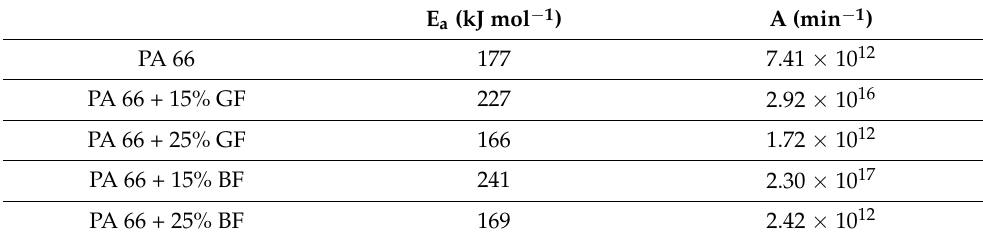
Table 2. Kinetic parameters using CR method.